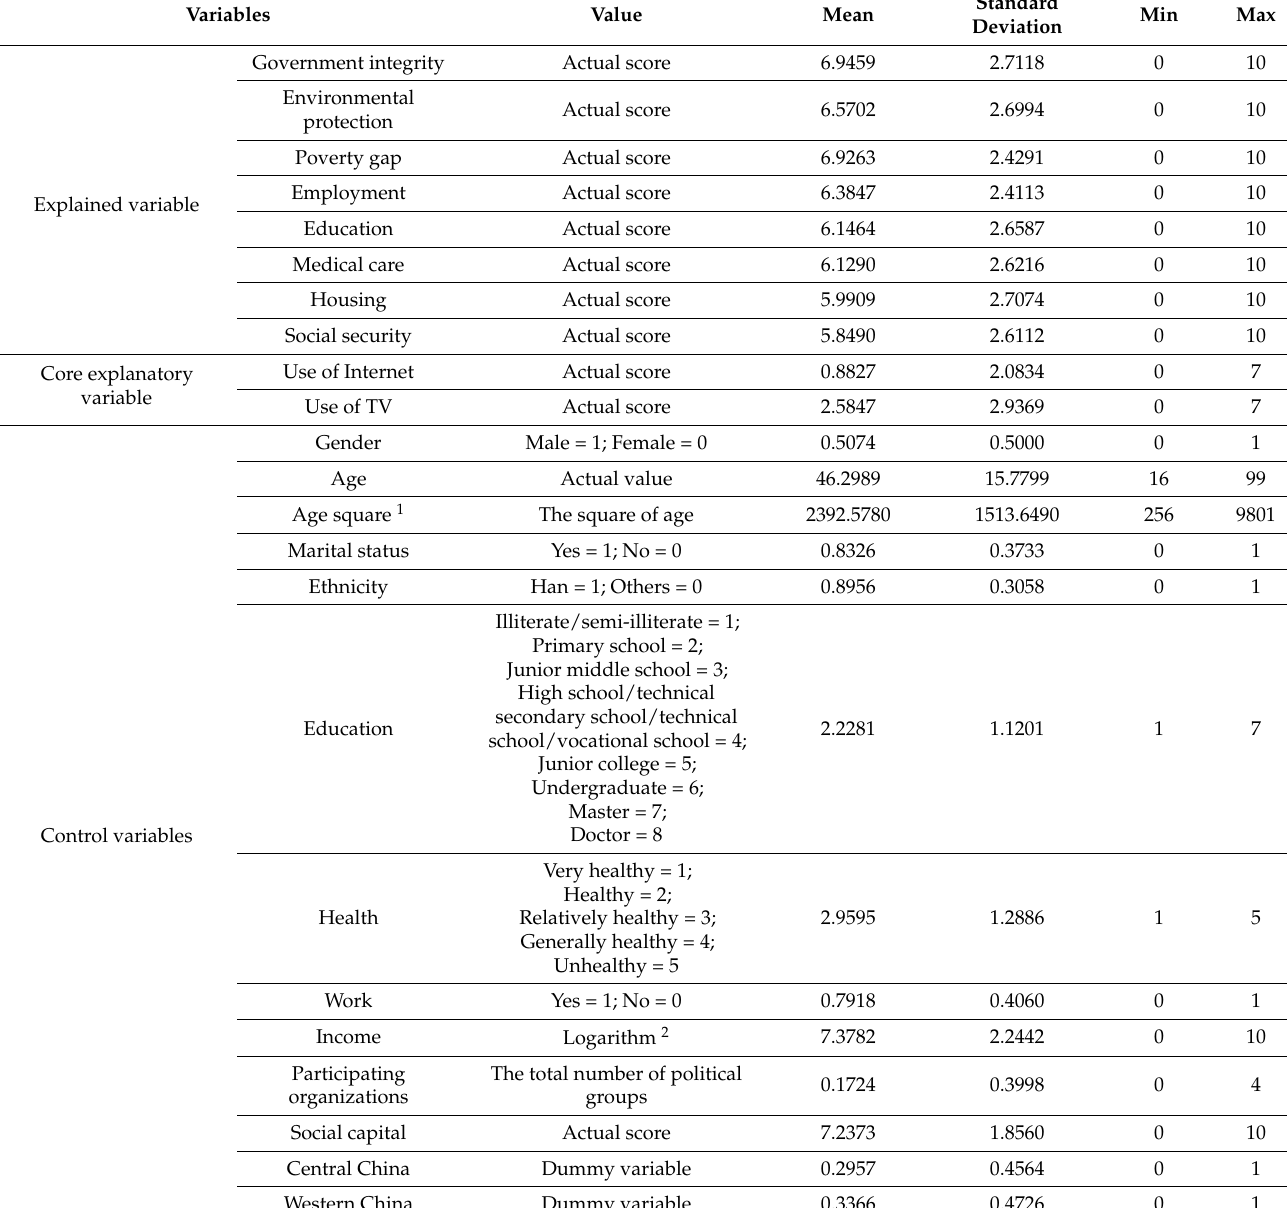
Table 1. Value of